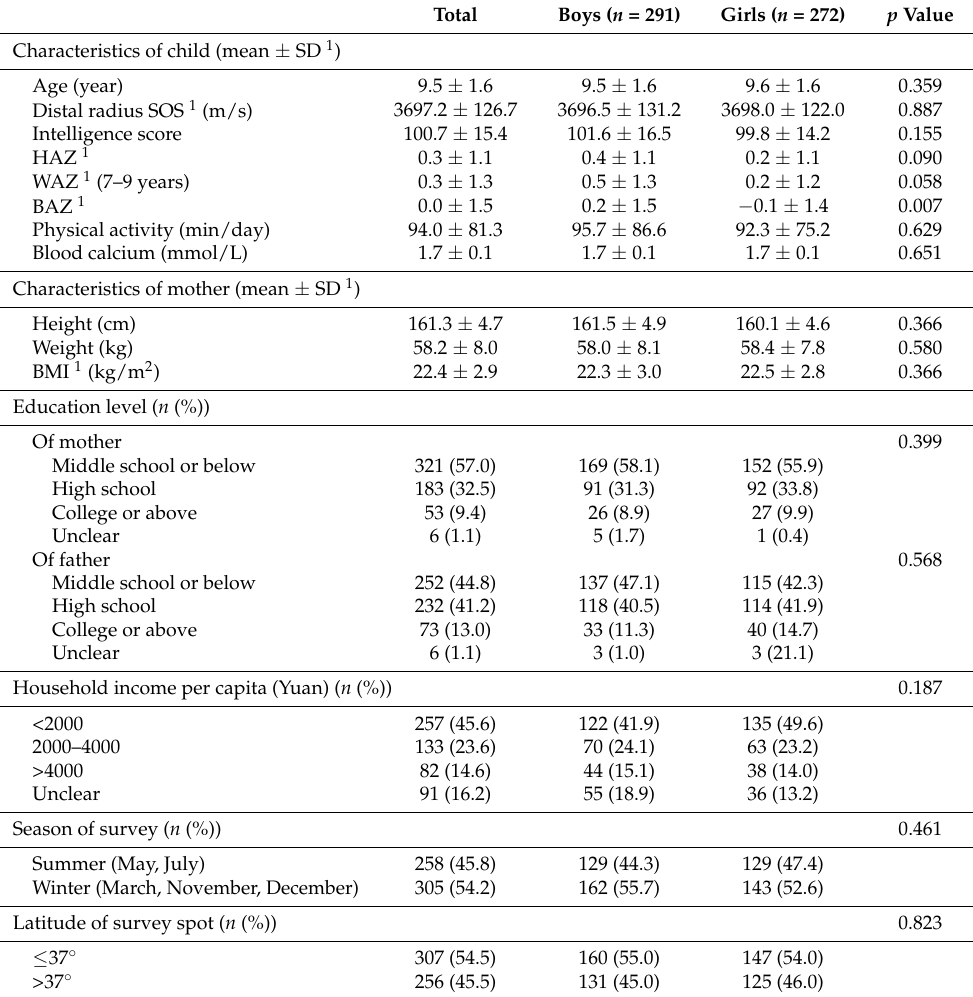
Table 1. Basic characteristics of participants by